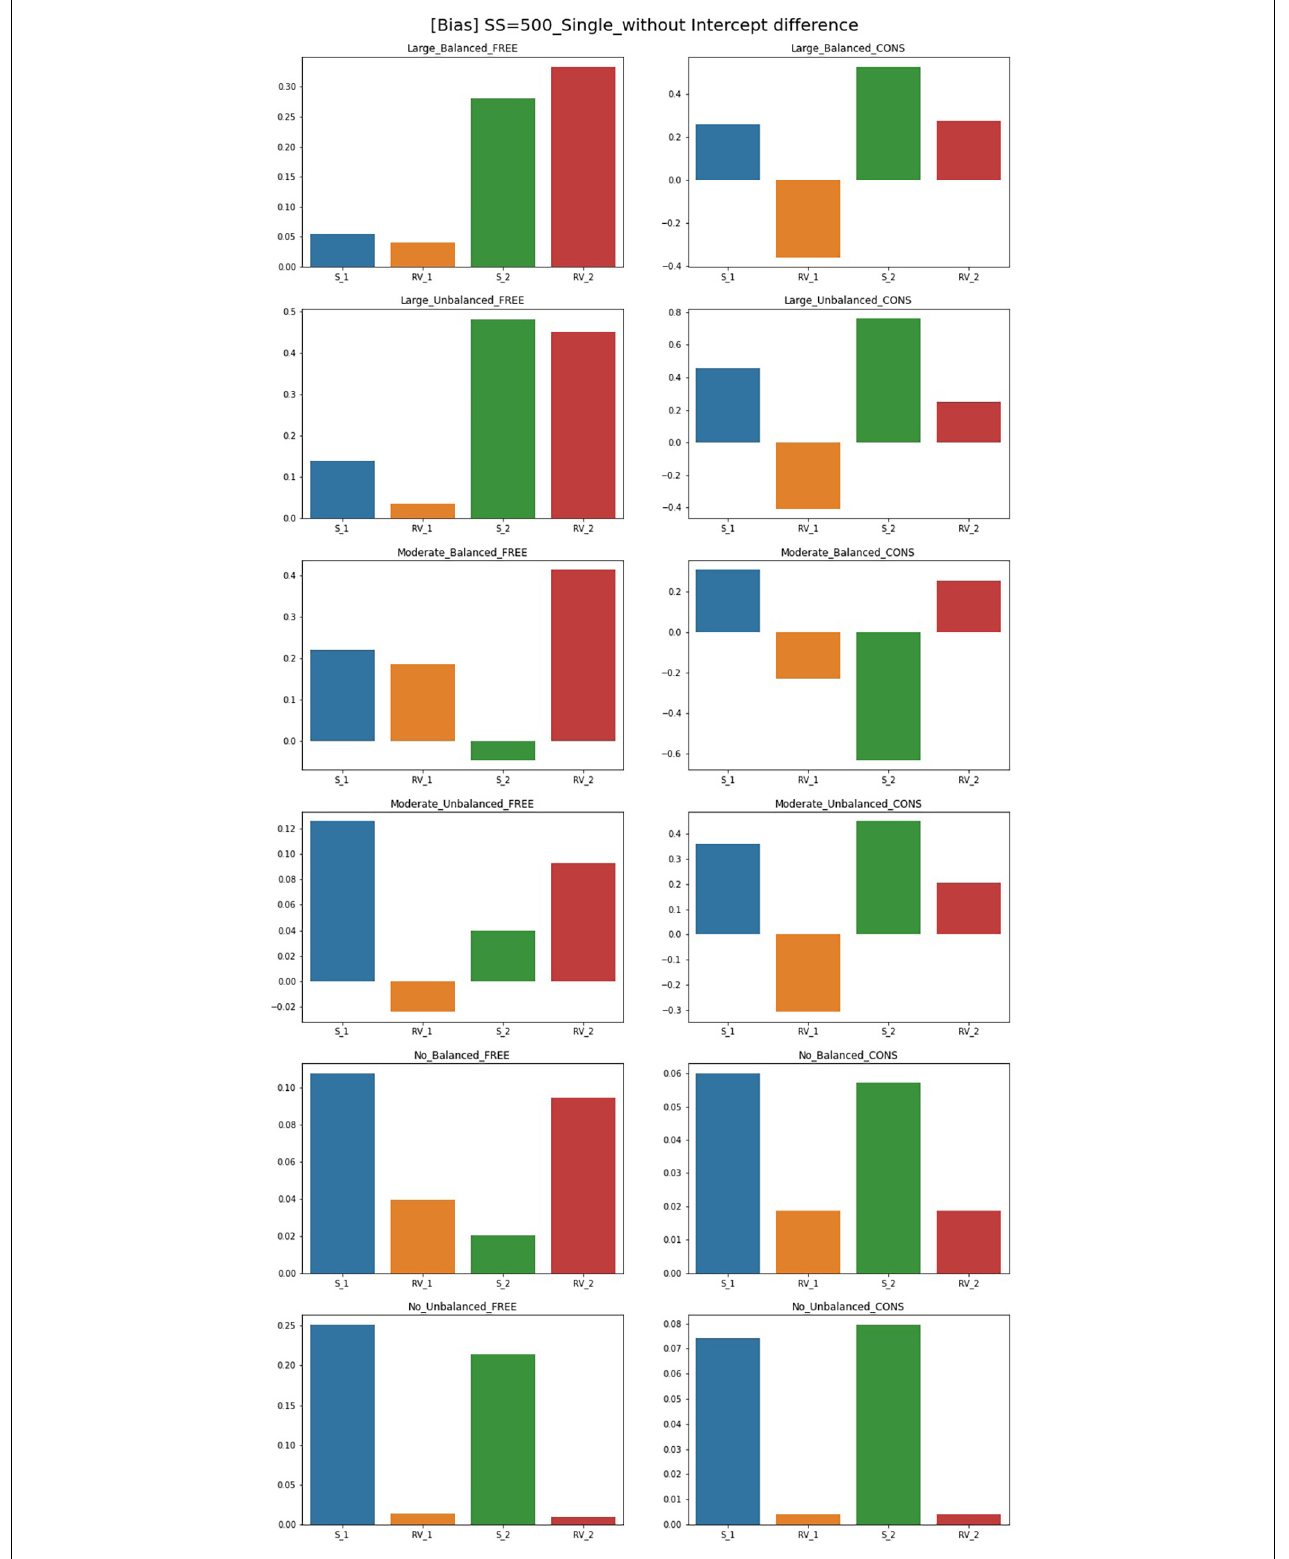
FIGURE 2 | Parameter bias of single-predictor models (sample size = 500, without intercept difference). Free, residual variances freely estimated; Cons, residual variances equally constrained; S_1, slope for class 1; RV_1, residual variance for class 1; S_2, slope for class 2; RV_2, residual variance for class 2.